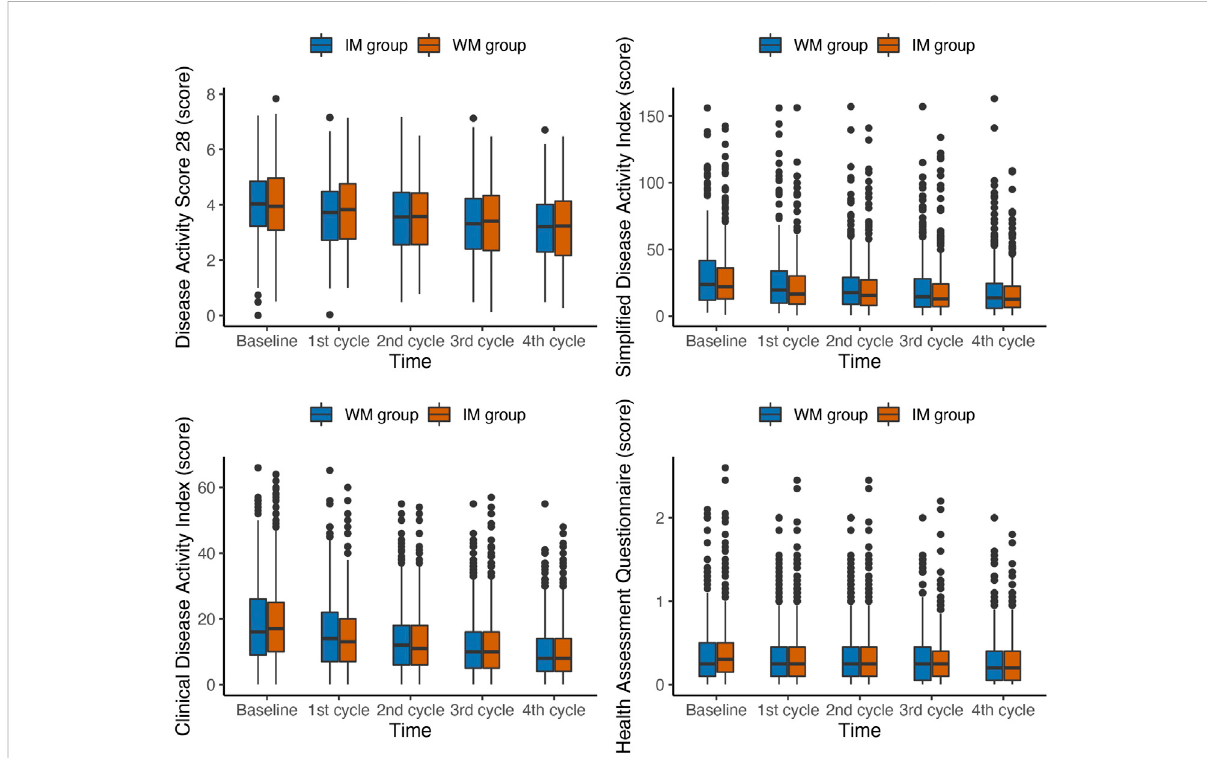
FIGURE 4 Box plots of changes in Composite outcomes during the fi rst year of follow-up in PP population. IM: Integrative medicine, WM: Western medicine, PGA, PhGA, patient ’ s and doctor ’ s global assessment of disease activity based on visual analogue